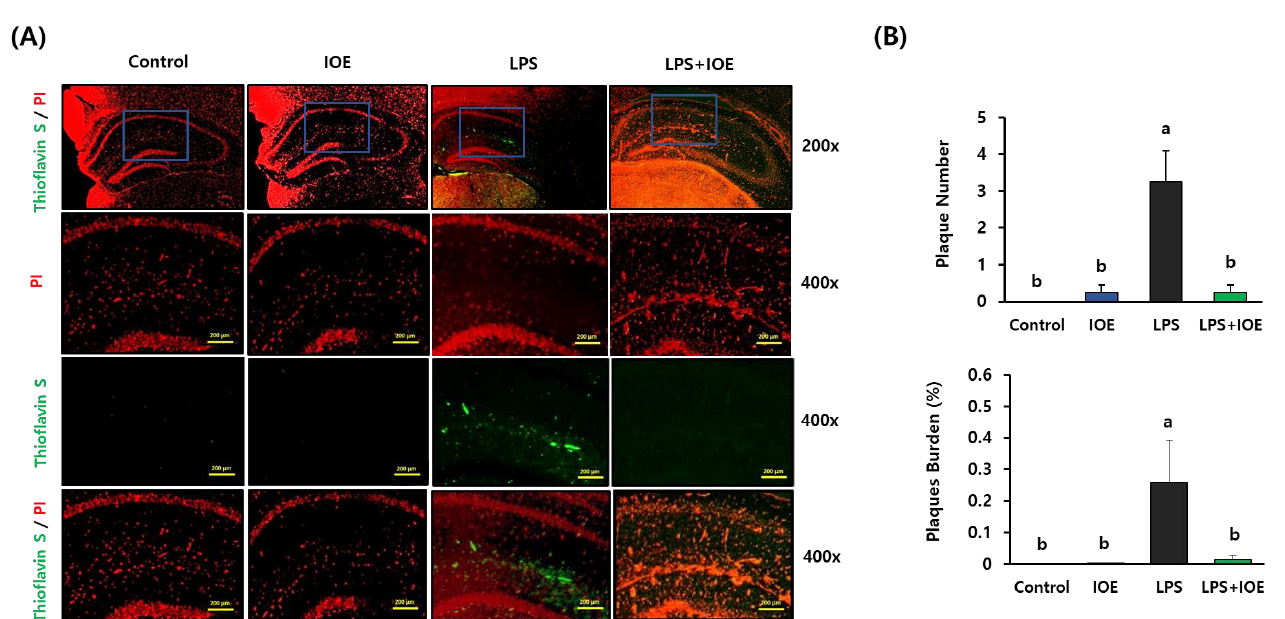
Figure 4. Oral administration of IOE attenuated the LPS- induced Aβ plaque formation in mice brain. The Hippocampal region of each mice group was stained with propidium iodide (PI) and Thioflavin S (green) ( n = 7) ( A ). The number of plaque and a percentage of plaque burden (plaque area/number of plaques) was calculated with the Image J program ( B ). Magnification 200× and 400×. Scale bar = 50 µm. Data shown are the mean ± SD and different letters (a,b) indicate the significant differences between groups ( p < 0.05). Each value is assigned as a and b sequentially from the highest value.